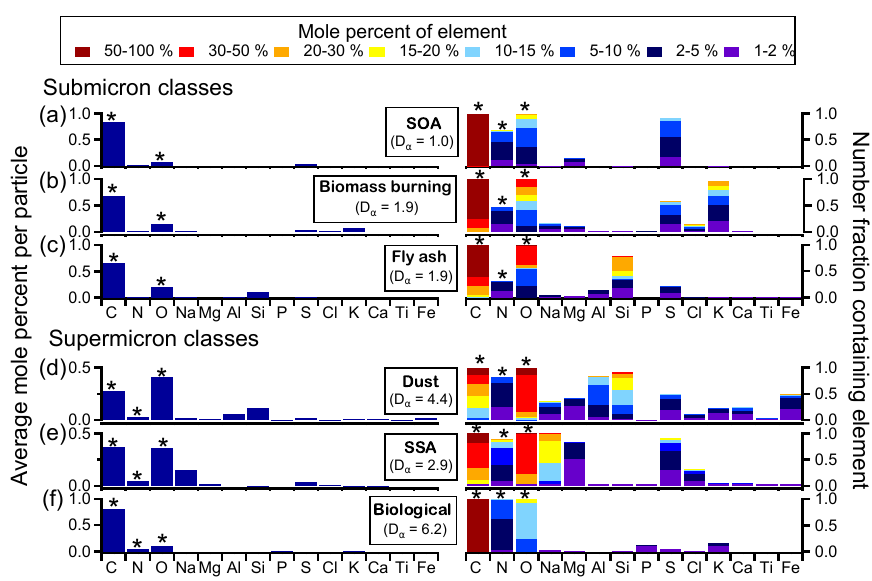
Figure 4. Average histograms and digital color histograms of different particle classes from SOAS: (a) SOA, (b) biomass burning, (c) fly ash, (d) dust, (e) SSA, and (f) primary biological. Average spectra are shown on the left as the average mole percent of each element analyzed by CCSEM-EDX (C, N, O, Na, Mg, Al, Si, P, S, Cl, K, Ca, and Fe). On the right, the digital color histogram heights represent the number fraction of particles containing a specific element, and the colors represent the mole percent of that element. The average particle specific diversity ( D α ) , representing the average number of elements in each particle, is calculated for each submicron and supermicron class and has an uncertainty of 5%–10%. Note the elements with an asterisk are not quantitative due to interference from the substrate or detector and are not included in D α